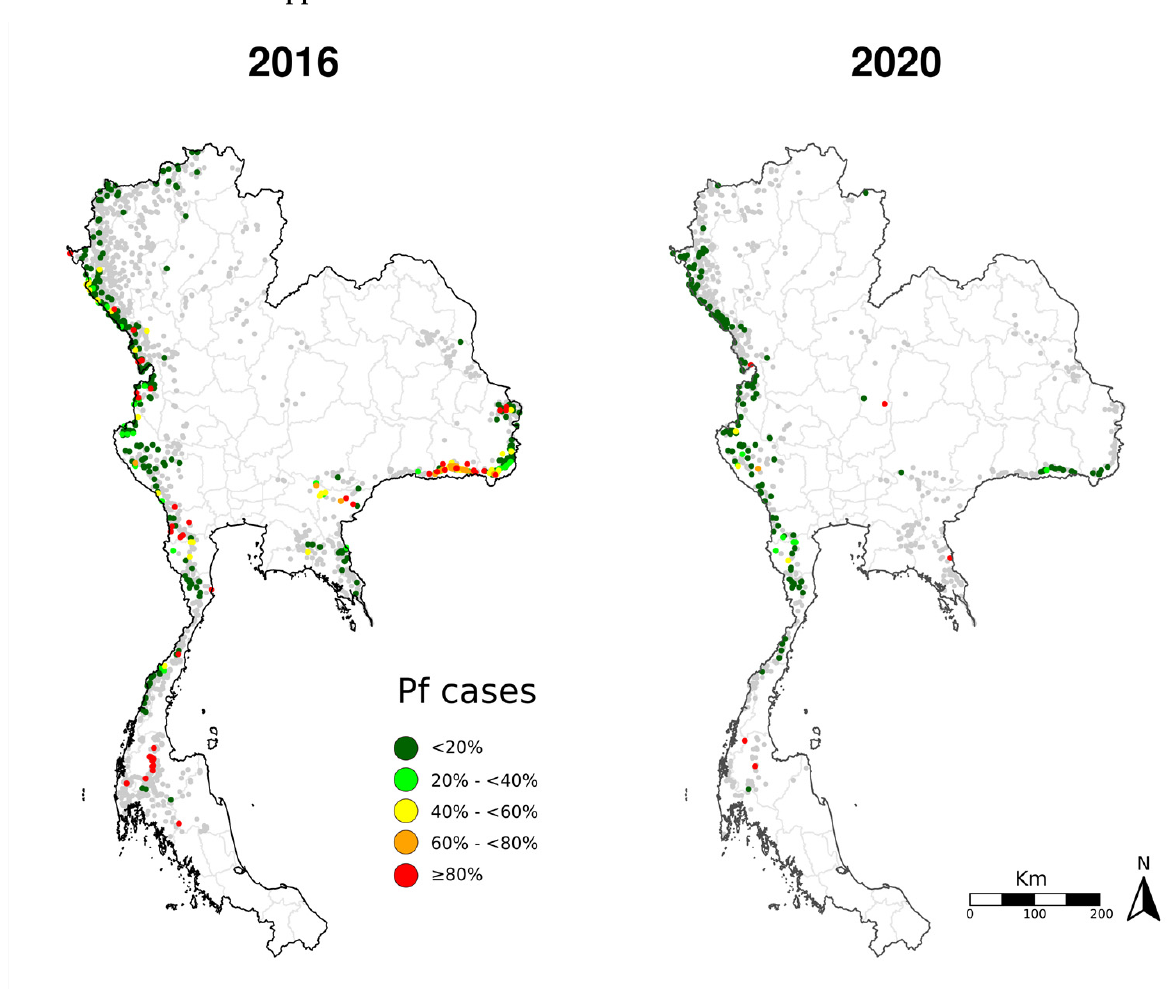
Figure A1. Percentage of Pf cases among reported cases in A1 foci in FY2016 and FY2020.